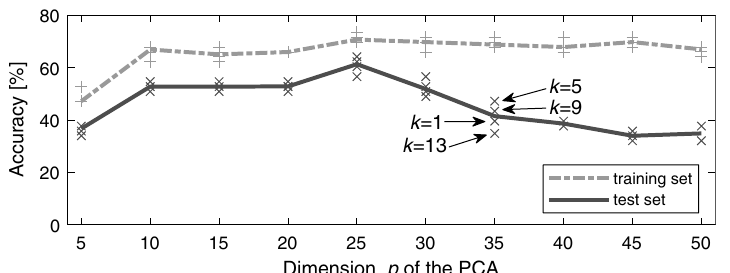
Fig. 2 Impact of the parameters p and k on the median accuracy for the small scenario with 25 households